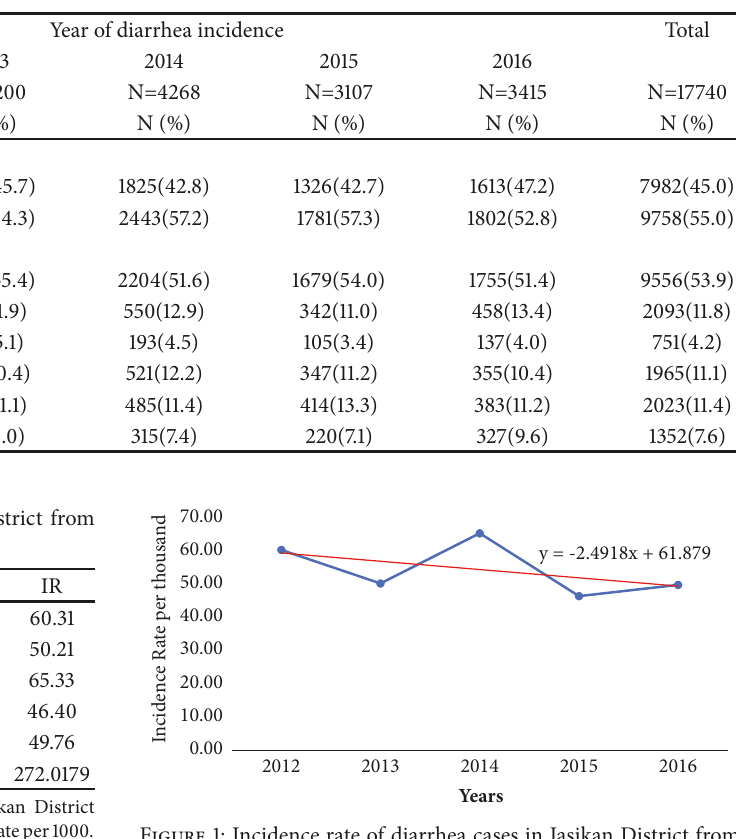
Table 1: Demographic characteristics of diarrhea cases in Jasikan District from 2012-2016.